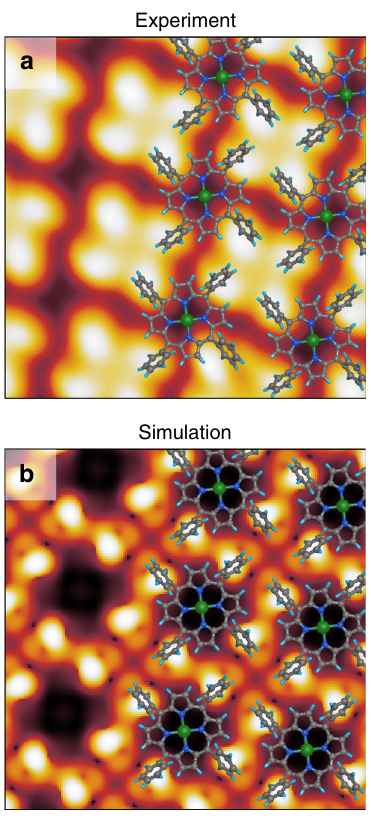
Fig. 3 STM measured and simulated images. a STM image on Ni-TPP/Cu (100) fi lm. Ni-TPP molecule is superimposed. STM image parameters: V b = + 1.5 V, I t = 0.5 nA, image size 3 × 3 nm 2 . b DFT simulated STM image using the relaxed structure shown in Fig.